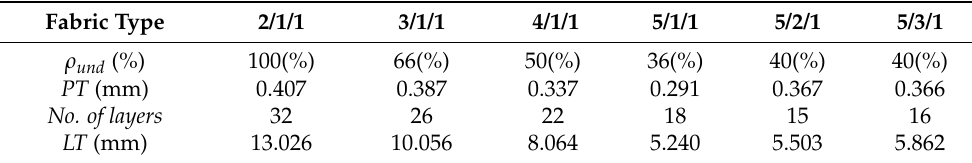
Table 10. The best solution when using various fabrics as reinforcement. Fabric